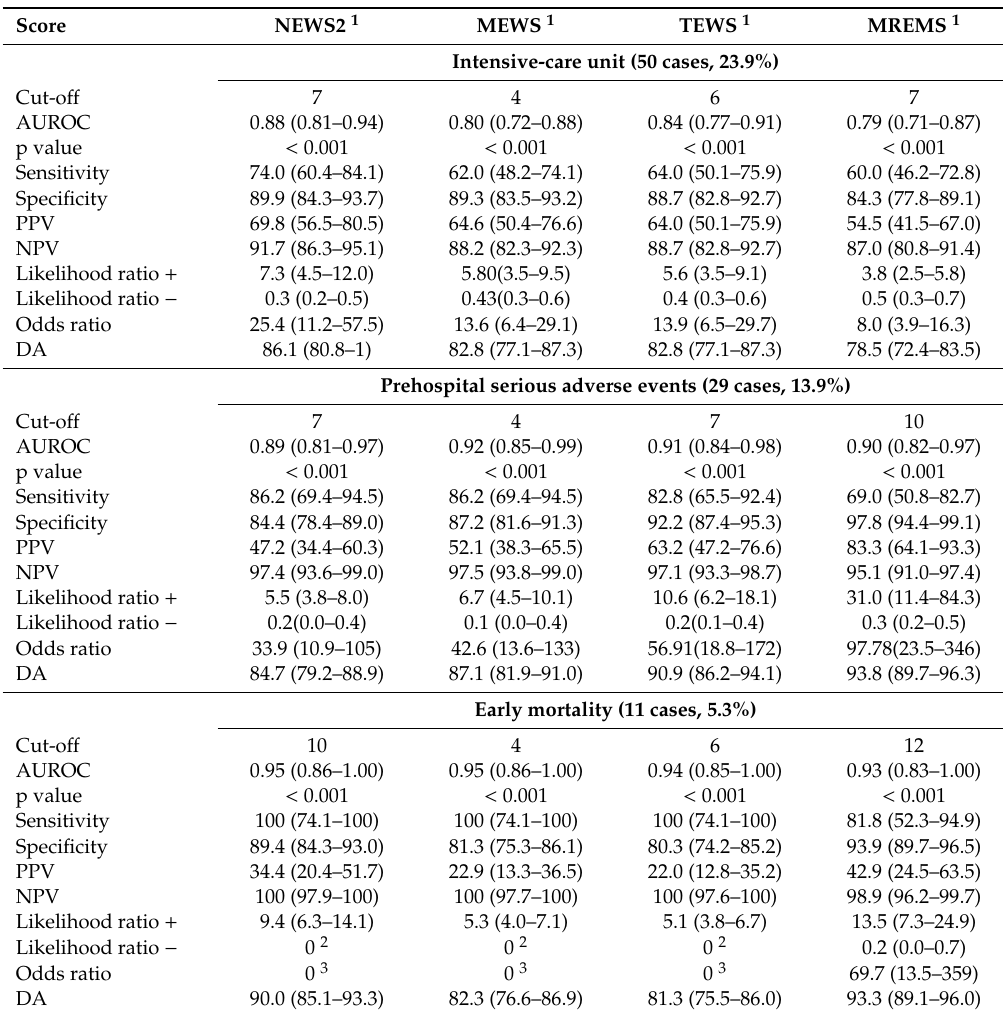
Table 3. AUROC, cut-o ff points for combined sensitivity and specificity with best score (Youden’s test) to NEWS2, MEWS, TEWS and MREMS for ICU, pSAEs and early